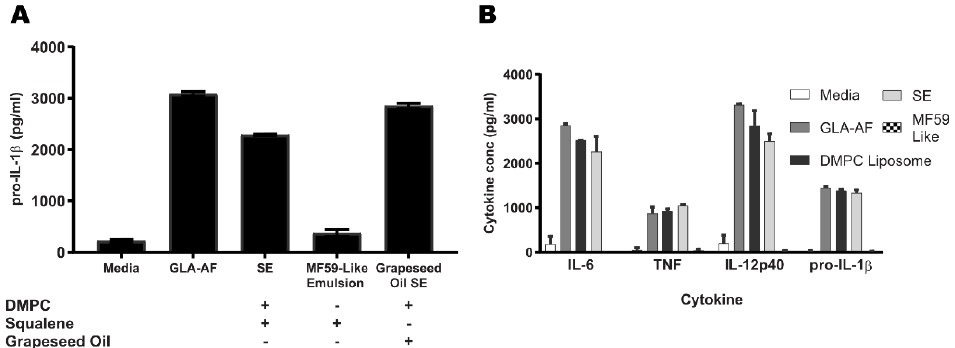
Figure 2. 1,2-dimyristoyl-sn-glycero-3-phosphocholine (DMPC) is necessary and sufficient for pro- IL-1 β and cytokine production. WT BMDCs were stimulated with media, GLA-AF, squalene SE, MF59-like emulsion, or grapeseed oil SE for 5 h. ( A ) Pro-IL-1 β production is ablated in DMPC-free emulsions. Lysate was collected and assayed for pro-IL-1 β by ELISA, using the formulations marked below the axis. ( B ) SE and GLA have similar cytokine profiles. WT BMDCs were stimulated as in ( A ) or with DMPC prepared as a liposome for 5 h. Lysates were assayed for pro-IL-1 β , IL-6, TNF α , and IL-12p40 by ELISA. Data are shown as the mean + / − SEM of n = 3–6 replicates. Data are representative of three experiments with similar results.